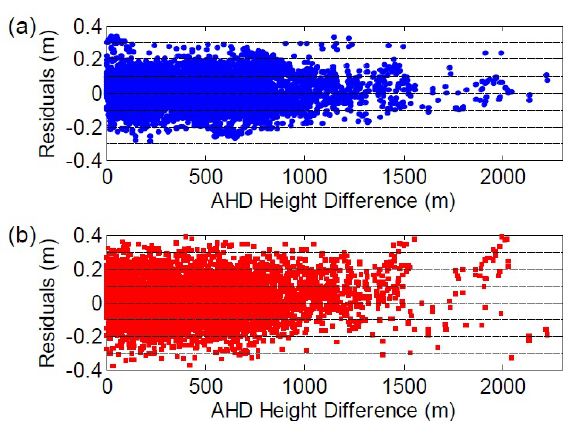
Figure 6: Snowy Mountains residuals between (a) AUSGeoid09- and (b) AUSGeoid98-derived and oflcial AHD height differences over 5,356 possible vectors as a function of AHD height